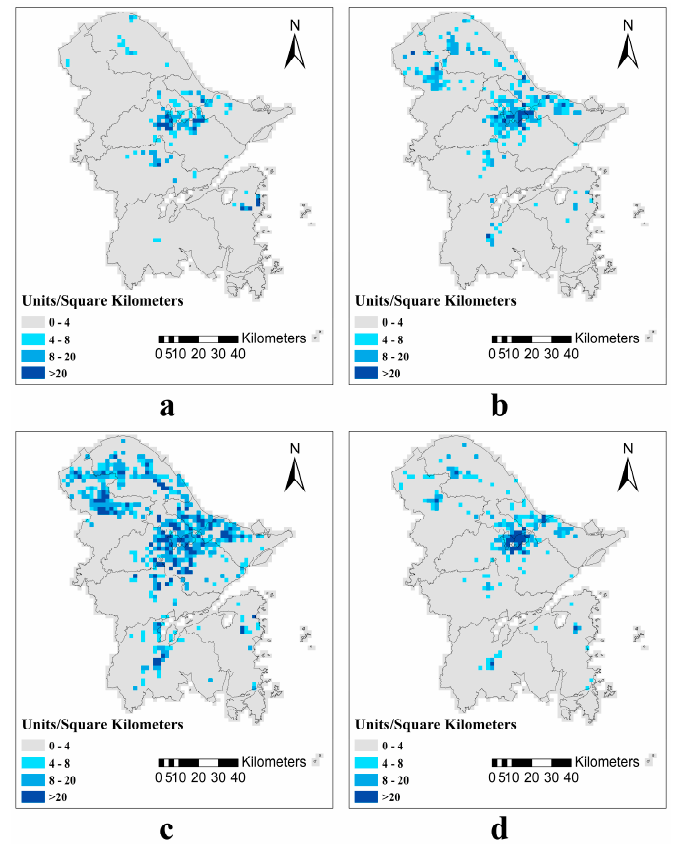
Figure 2. The density maps of ( a ) textile enterprises; ( b ) chemical product enterprises; ( c ) metal product enterprises; and ( d ) other enterprises in the study area (Units/km 2 ). Rhyolitic, tuffaceous residual slope faces dominated the parent materials (Table 3 and Figure 3a) in the study area. Lakes and marshes extended over large parts of the north-central part of the study area, while coastal sedimentary parent materials covered large areas of the northern and southern parts. The main soil types (Table 4 and Figure 3b) were divided into paddy, fluvo-aquic, red, coastal